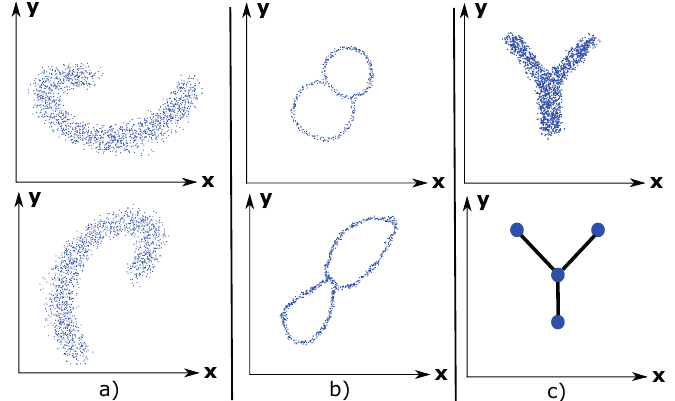
Figure 1. Frameworks TDA inherits from topology. ( a ) Coordinate invariance . The dataset has been rotated approximately 100 degrees clockwise. ( b ) Deformation invariance . The dataset has been stretched along the y = x line. ( c ) Compression of a dataset into 4 nodes and 3